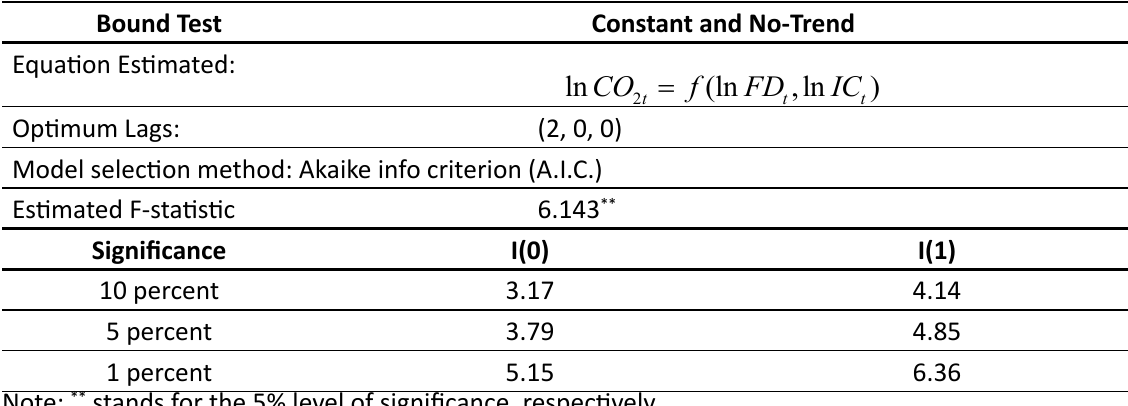
Table 5: ARDL Bound Test